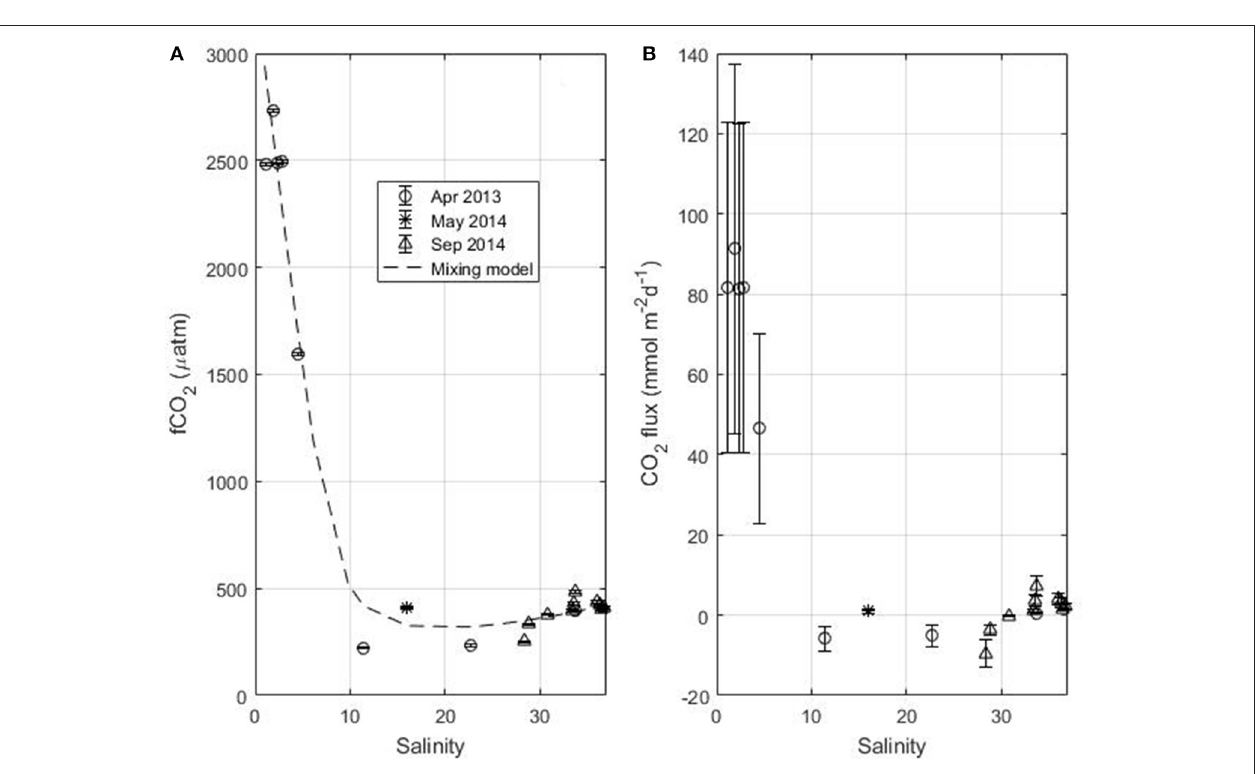
contribution of organic species in the expression of